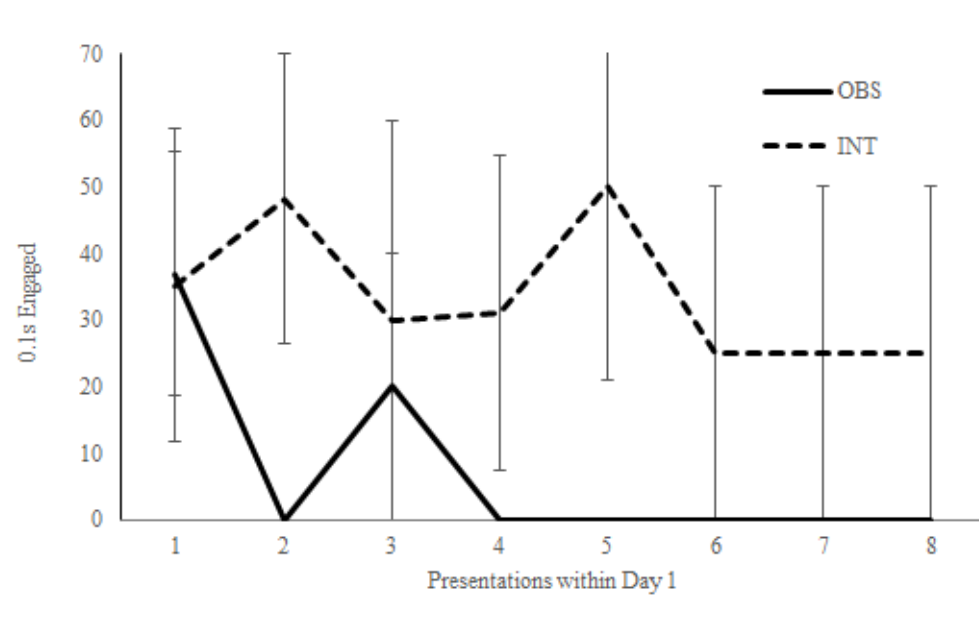
Figure A4. Within the first day of Experiment 3, presence on the far platforms immediately prior to the eight response- independent stimulus presentations, in order. There were insufficient data within the first day to ascertain whether the apparent interaction was reliable or not. Error bars indicate